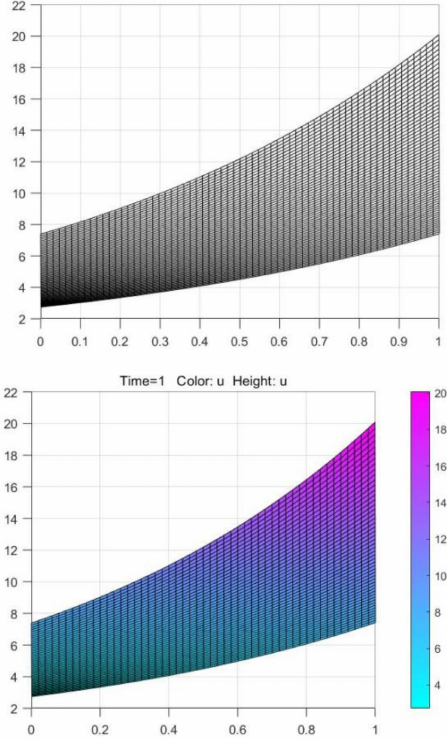
Figure 5. Cross-sectional